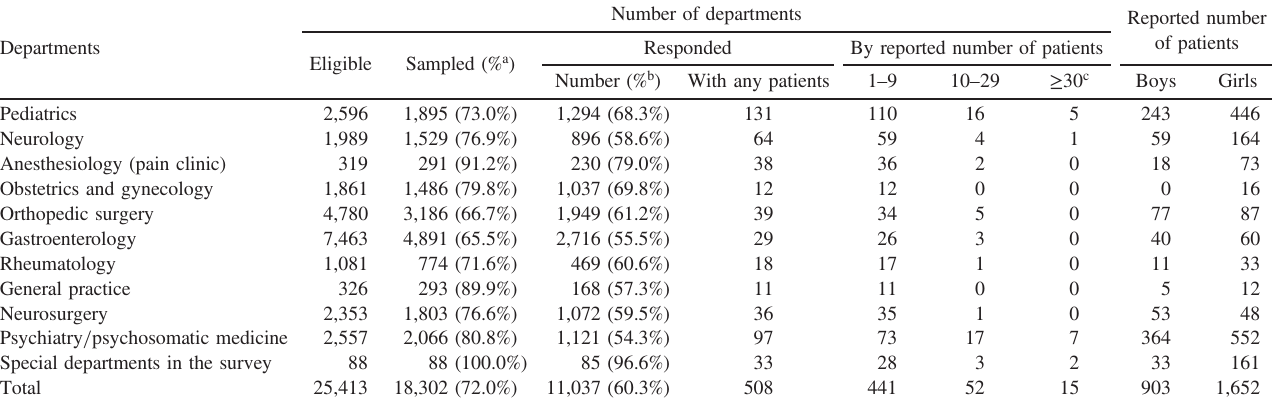
a Number of sampled = Number of eligible. b Number of responded = Number of sampled. c The maximum number was 136